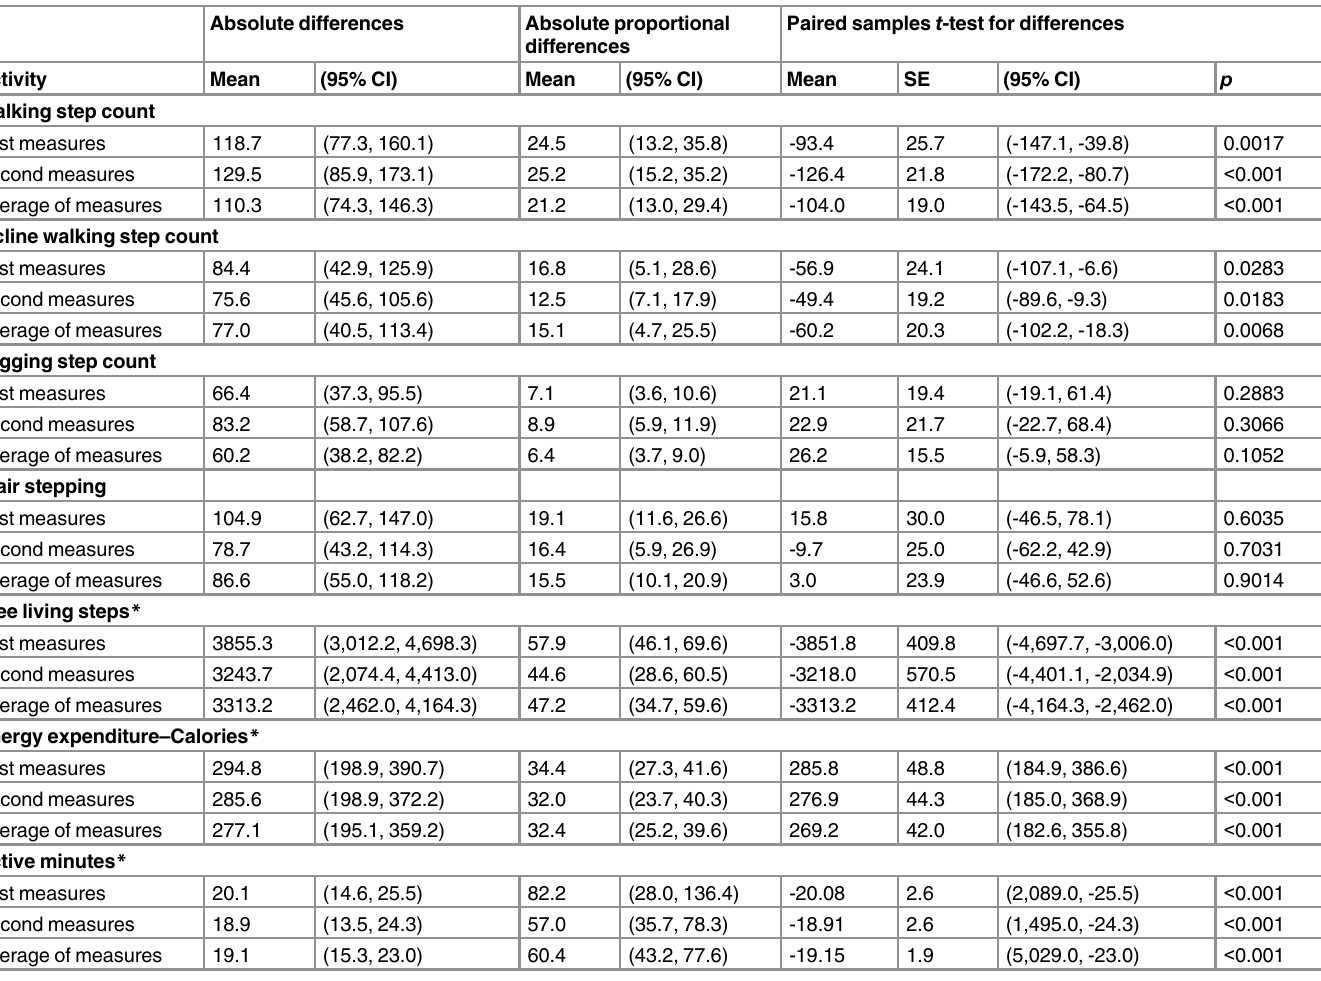
Table 2. Comparisons and differences of direct observation and the Fitbit in the laboratory and the Fitbit and Actigraph in free living. Absolute differences Absolute proportional Paired samples t -test for differences